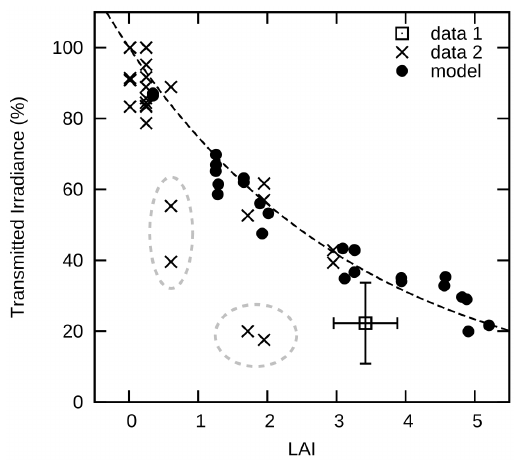
Figure 3. Percentage of downwelling top of canopy PAR irradiance reaching the substrate, as a function of LAI. Results for empirical in-situ measurements (data 1 and 2) and modelled estimates (model) are shown. Curve fit to model data points is y =100 * exp( 2 0.29 6 LAI). 6 (data 2) - are 26 individual coincident measurements of LAI and irradiance above and below the canopy. ^ (data 1) is a single point based on a site mean of 13 LAI determinations from 2.84 to 4.09 and a set of associated but not spatially co-incident